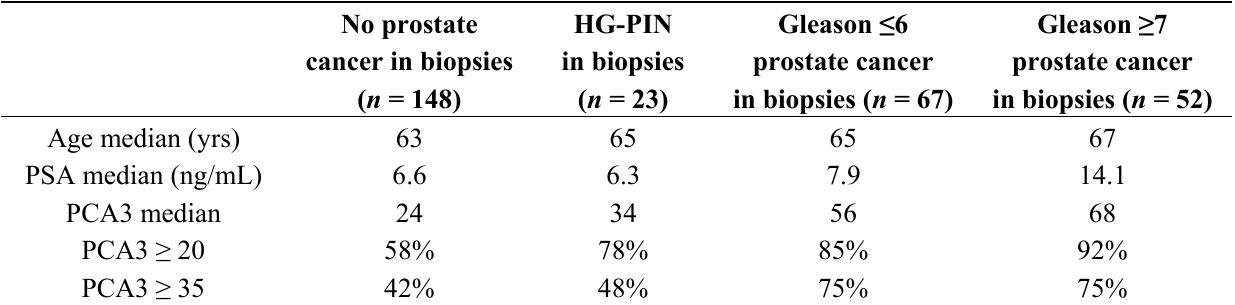
Table 2. PSA and PCA3 characteristics of patients who underwent biopsies within six months after the PCA3-test, sorted by biopsy